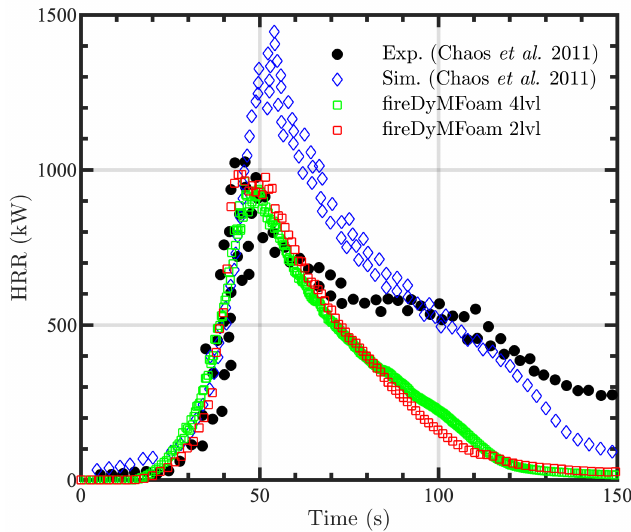
Figure 8. Time history of chemical heat release rate (HRR) for the two-panel fire spread validation case. Experimental and simulation results from Chaos et al. [40] are shown as black circles and blue diamonds, respectively, and AMR simulation results from fireDyMFoam using four levels of refinement and two levels of refinement are shown as green and red squares,